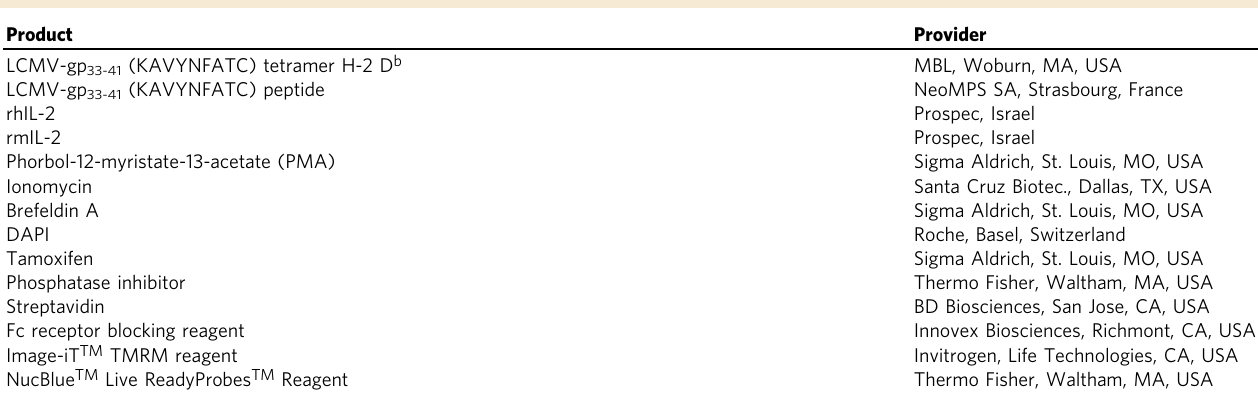
Table 1 Chemicals, peptides, and recombinant